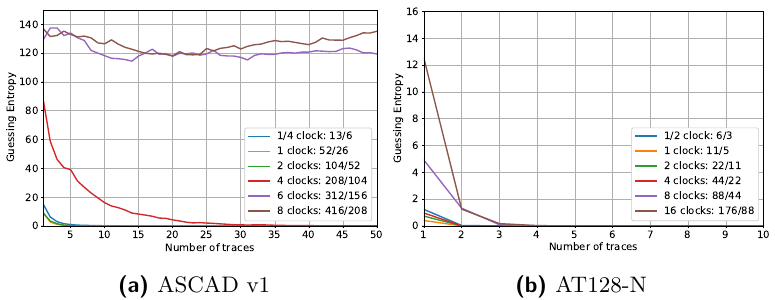
Figure 12: Results of different choices on the filter size and stride in LC